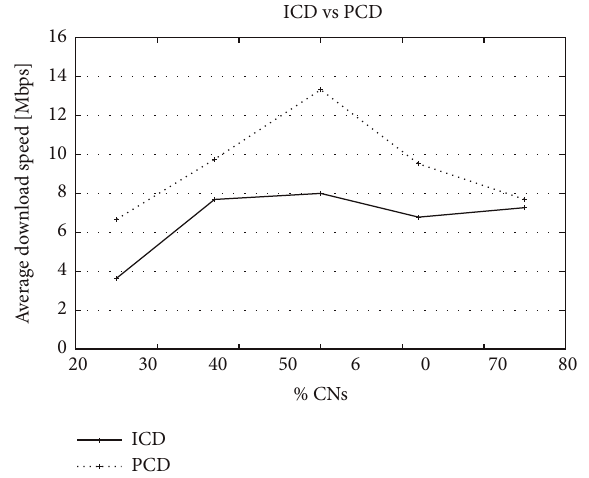
Figure 17: Average download speeds achieved for the augmented AppNs (in ICD and PCD) against different ratios of CNs within the